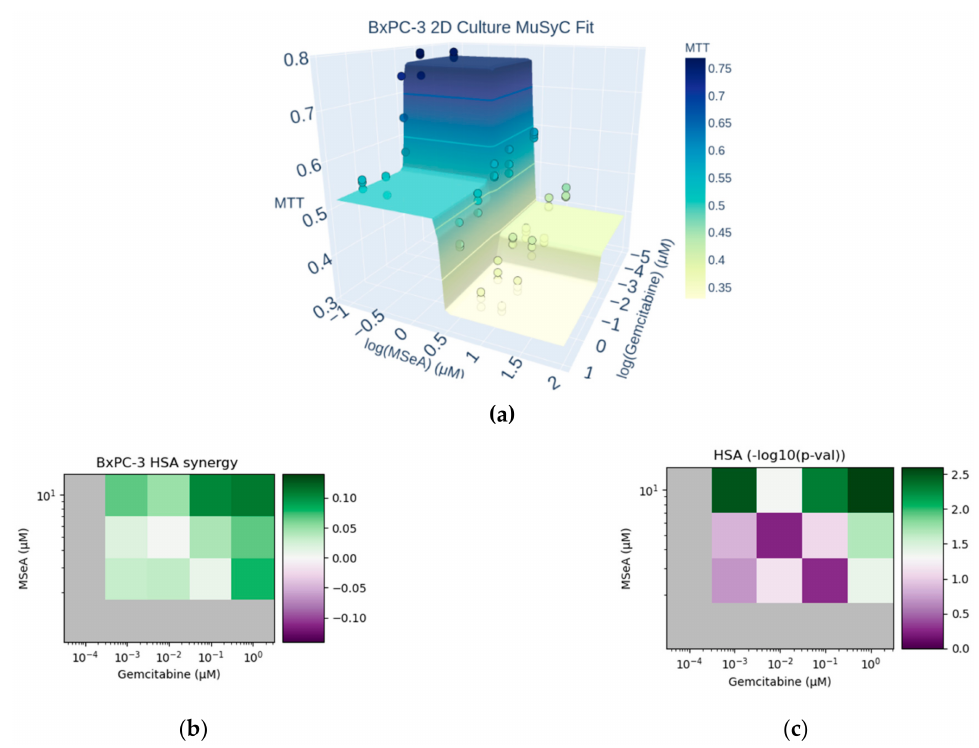
Figure 1. MuSyC and HSA synergy of Gemcitabine + MSeA in BxPC-3 cells grown in 2D culture. ( a ) Scatter points show raw response data, while the surface corresponds to the best MuSyC fit following 24 h treatments. Dose axes are on a log scale. A fully interactive version of this figure is in File S2. The MuSyC parameters used to generate this surface are given in Table S1. Synergistic efficacy can be seen by the fact that the deepest response is seen at high concentrations of the combination of Gemcitabine + MSeA. ( b ) Dose-dependent HSA synergy, averaged over triplicate measurements. The gray values correspond to treatment with a single drug, where synergy is not definable. Values with HSA > 0 are synergistic, while those with HSA < 0 are antagonistic. Raw HSA values are reported in Table S2. ( c ) Statistical significance of the HSA synergy from panel ( b ), determined by two-sided, one-sample t-test. Color corresponds to -log10(p). The color scale is centered so that white corresponds to p = 0.05, green corresponds to p < 0.05, and purple corresponds to p >